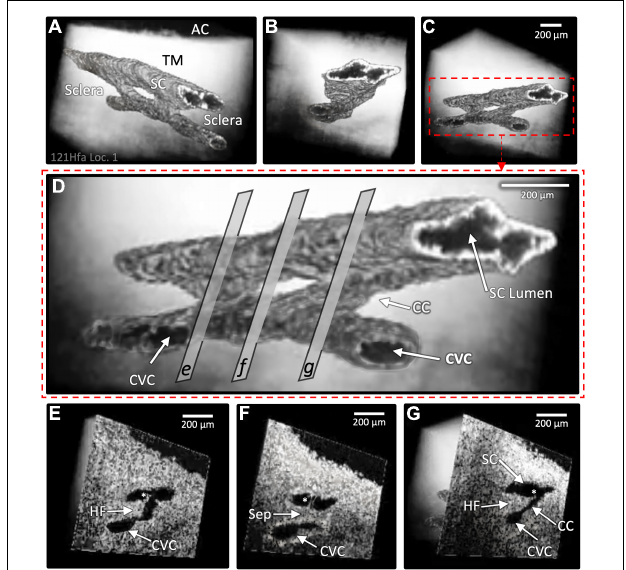
FIGURE 4 | Two collector channels (CC): Architecture and internal relationships. Images (A–D) show the surface architecture of the outflow system in a region encompassing two CC that communicate with a circumferential vascular channel (CVC) parallel to SC, which were obtained after segmentation of lumens (dark appearance) in the 3D OCT images. Image (D) magnifies image (C) to show cross-sectional slices through regions (E–G) that represent locations of the 3D images in the lower panel of the cross-sectional images (E–G) at the exact location. Both CC lumens are short segments oriented perpendicular to the SC and CVC lumen; the lumens of SC and CVC are parallel. The region between the CC in (F) and the CVC is separated from SC by a septum (Sep) that appears as a void in (D) . The lumens of SC, the CC, and CVC experience synchronous motion in response to SC pressure changes. In (E,G) , asterisks identify hinged flaps (HF) at CC entrances. In (F) , a cylindrical attachment structure with lumen bridges between the TM and SC external wall ( Supplementary Video 3